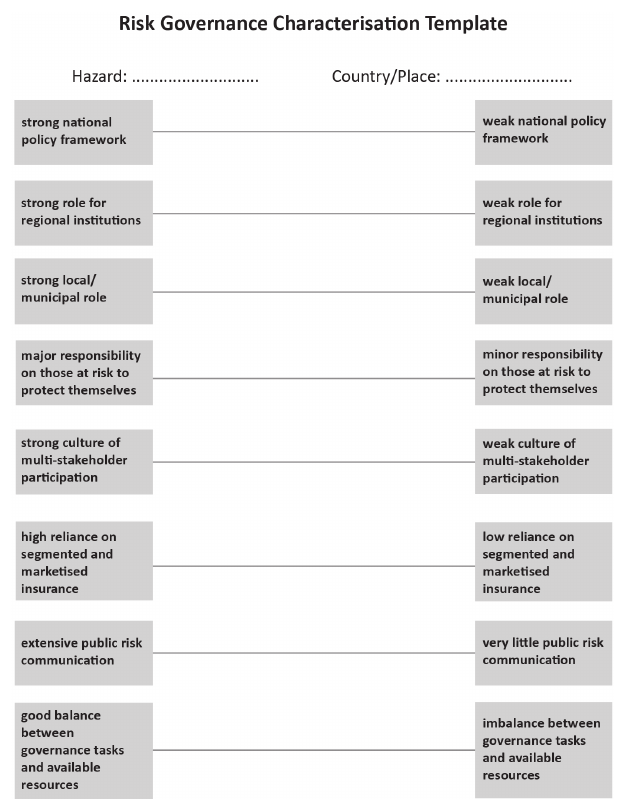
Fig. 1. Risk governance characterisation